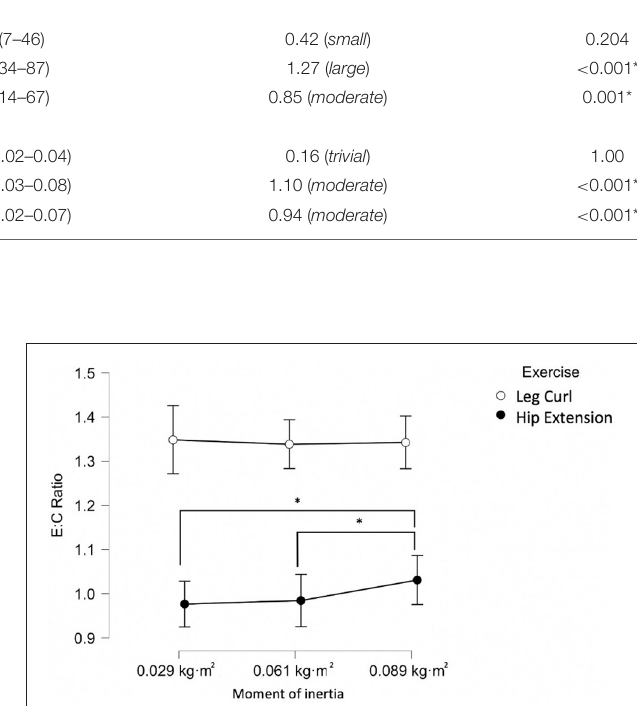
mean difference (95% CI)